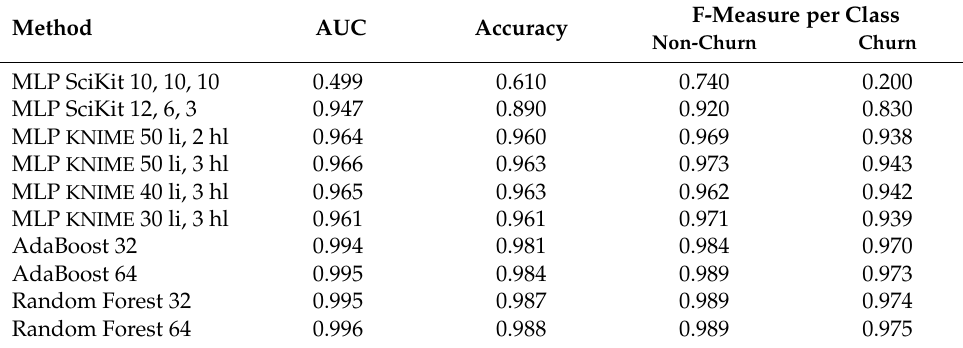
Table 2. Development phase: assessment of models’ setup variants. Method